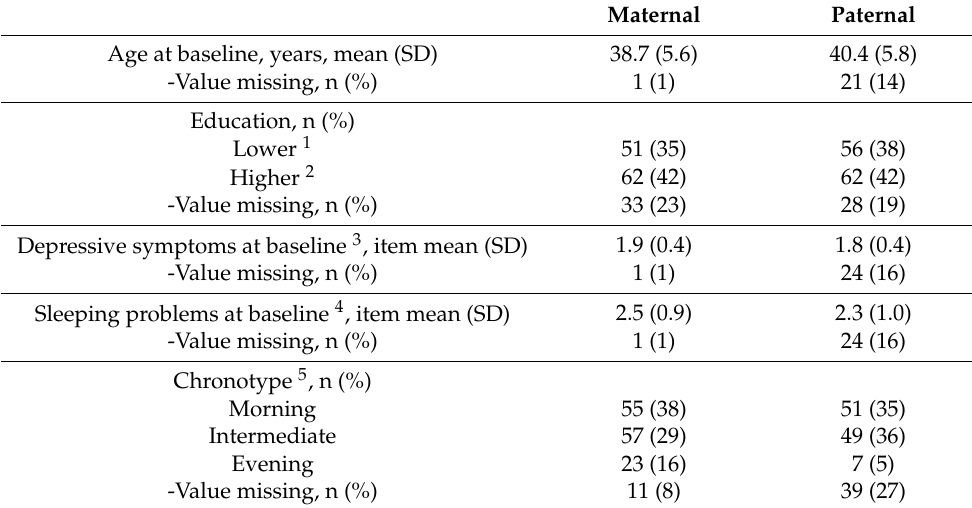
Table 2. Characteristics of all the parents whose children participated in the